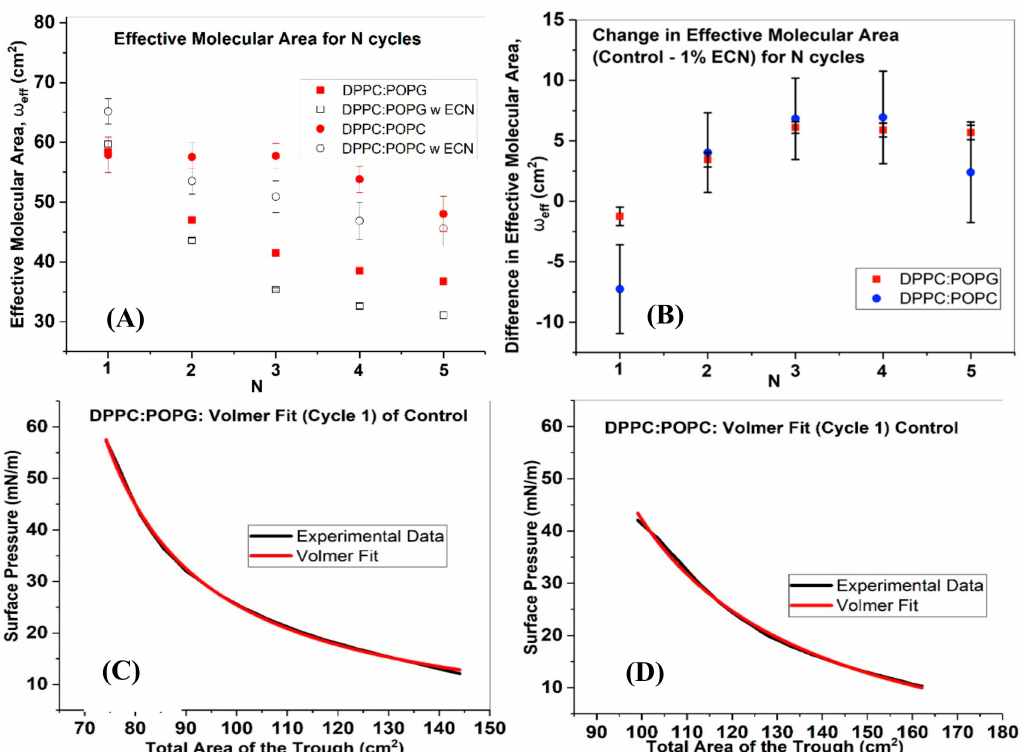
Figure 6. E ff ective molecular area and di ff erence in e ff ective molecular area derived by fitting Volmer’s equation to Π –A isotherms. ( A ) One of the parameters of equation 3 is the e ff ective molecular area, denoted by ω e ff . ω e ff as a function of compression / expansion cycle was plotted for DPPC:POPG (7:3) control (closed square), DPPC:POPG (7:3) with 1% ECN (open square), DPPC:POPC (7:3) control (closed circle) and DPPC:POPC (7:3) with 1% ECN (open circle). ( B ) A di ff erence in ω e ff between the control and1% ECN has been plotted for DPPC:POPG (7:3) (red square) and DPPC:POPC (blue circle). The data has been represented as the mean and standard deviation of 3 samples. ( C ) and ( D ) Experimental data and Volmer fits to the first cycle for DPPC:POPG and DPPC:POPC demonstrate the quality of the